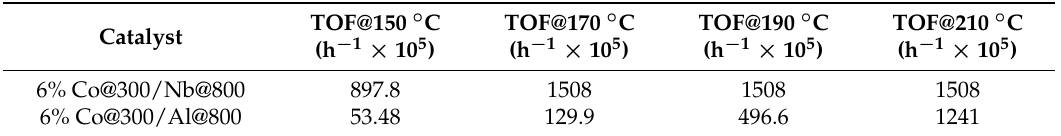
Table 3. Turnover Frequencies (TOF) for CO oxidation for fresh 6% Co@300/Nb@800 relative to fresh